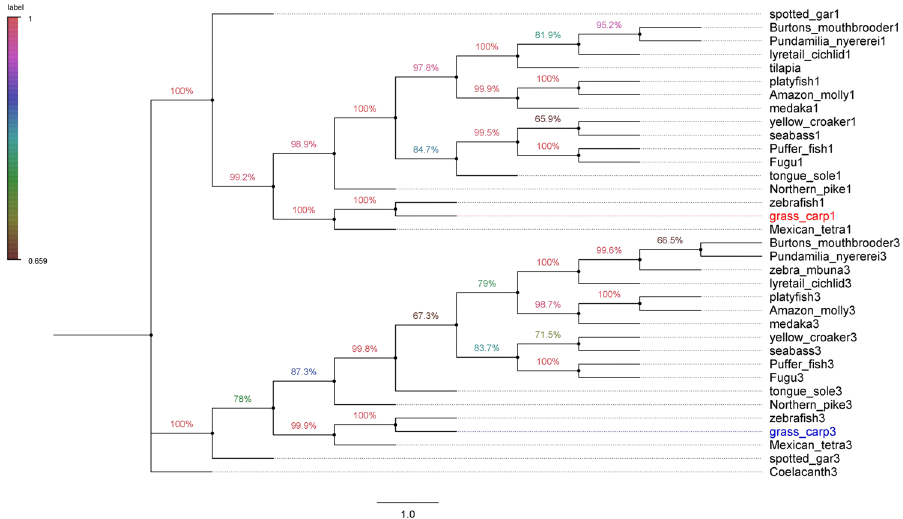
Figure 3. Phylogenetic analysis of fish T1R1 and T1R3. A phylogenetic tree was generated by the Maximum Likelihood method of MEGA7.0 (http://www.megasoftware.net/). The numbers at branch points represent bootstrap values (1000 repetitions). The scale bar indicates the relative measure of evolutionary distance. Amino acid sequences available in the EMBL/GenBank databases and food habit information of fish are shown in Table 3.